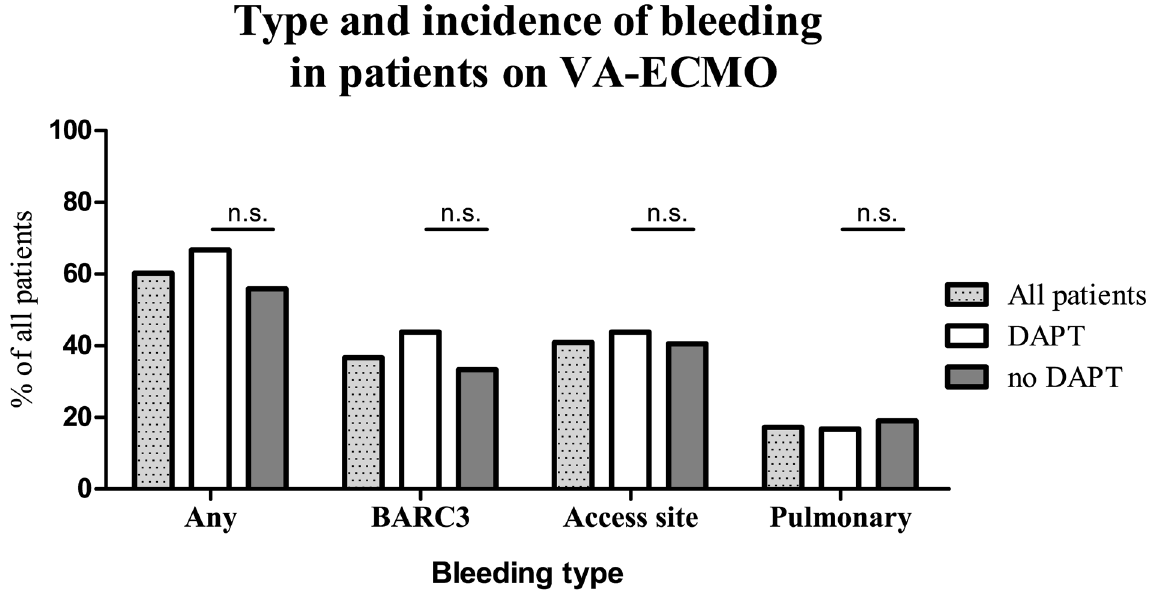
Fig 1. Bleeding incidence on venoarterial extracorporeal membrane oxygenation therapy, bleeding incidence during venoarterial extracorporeal membrane oxygenation therapy is given as percentage of patients with bleeding to total patients